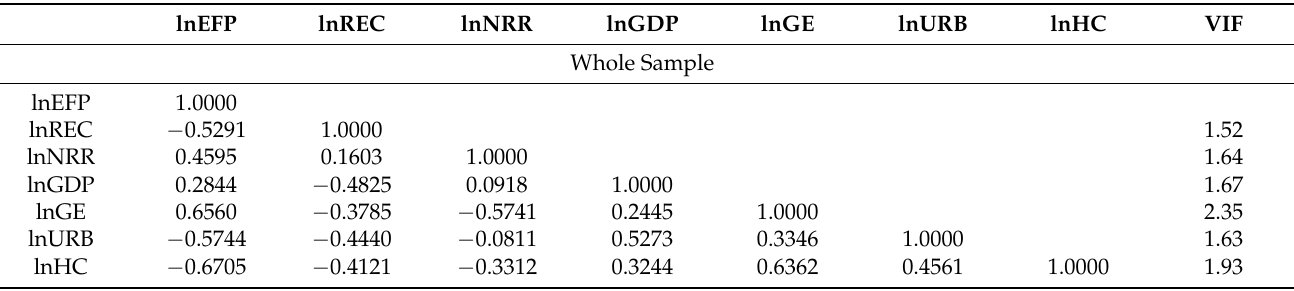
Table 3. Correlation and VIF